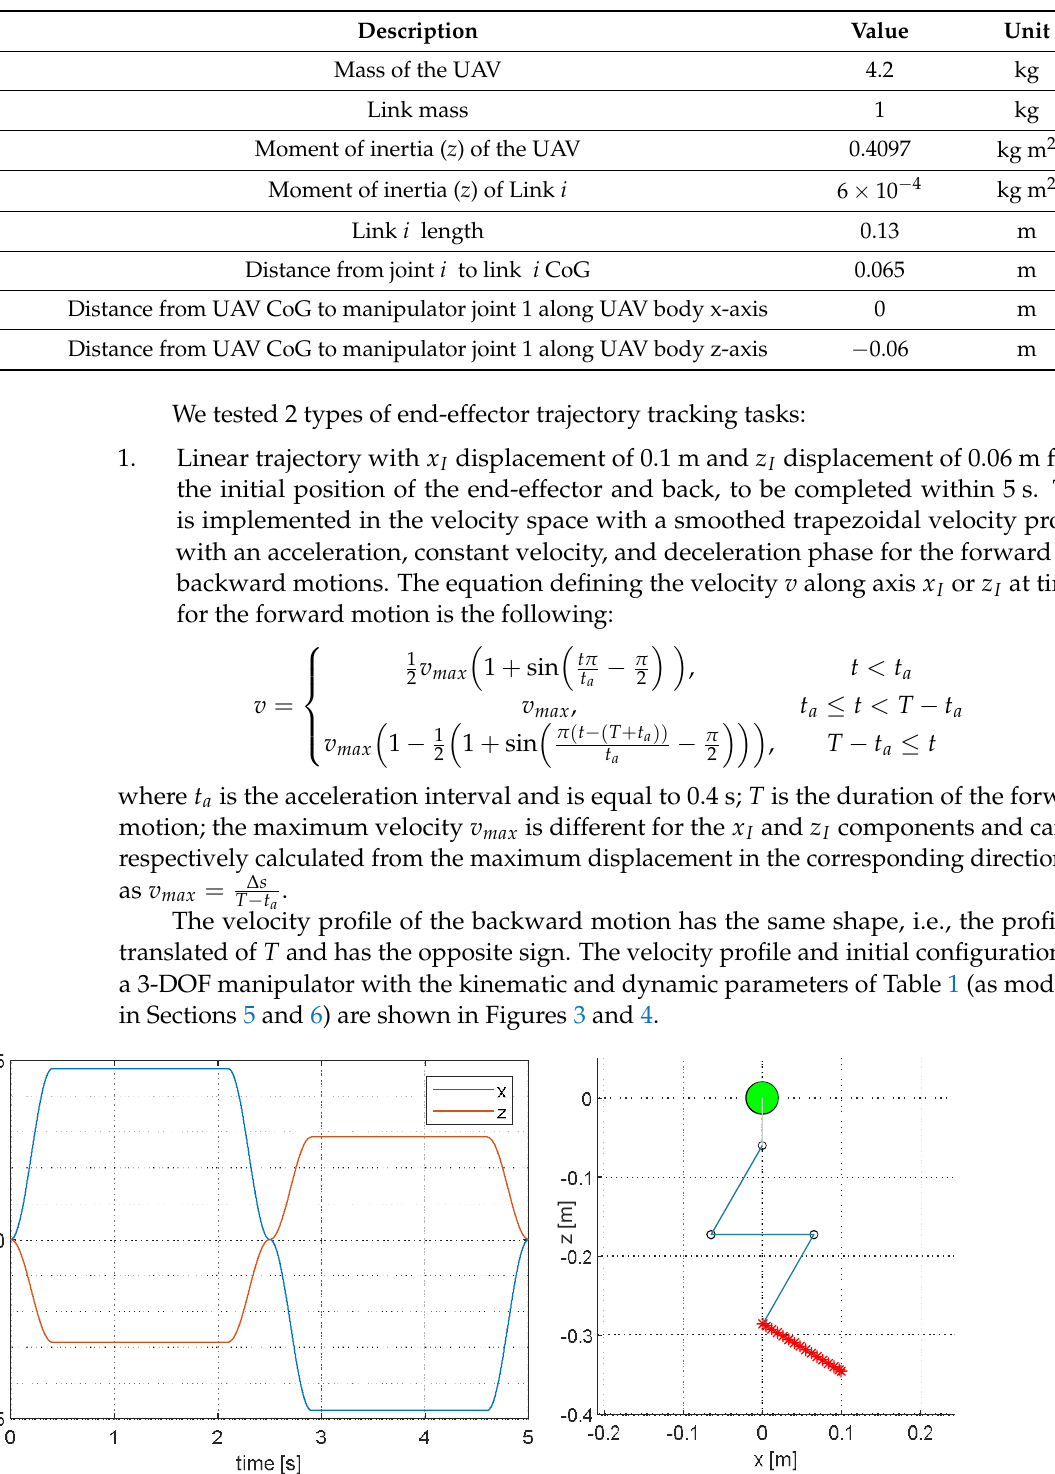
Table 1. Kinematic and dynamic UAM model parameters used in simulation experiments.